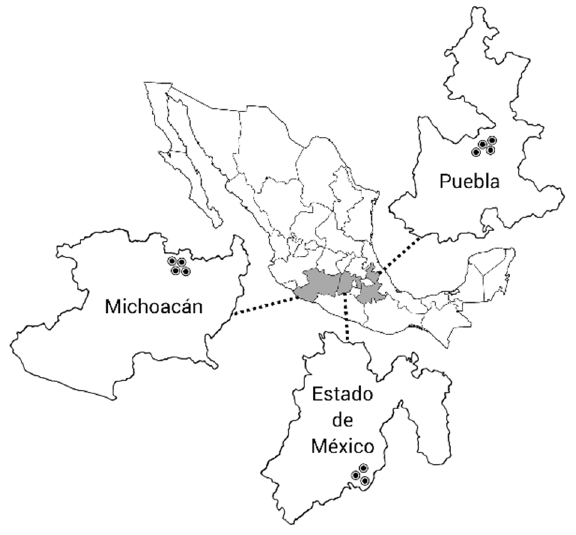
Figure 1. Region of Mexico were crops and sampling sites were developed.